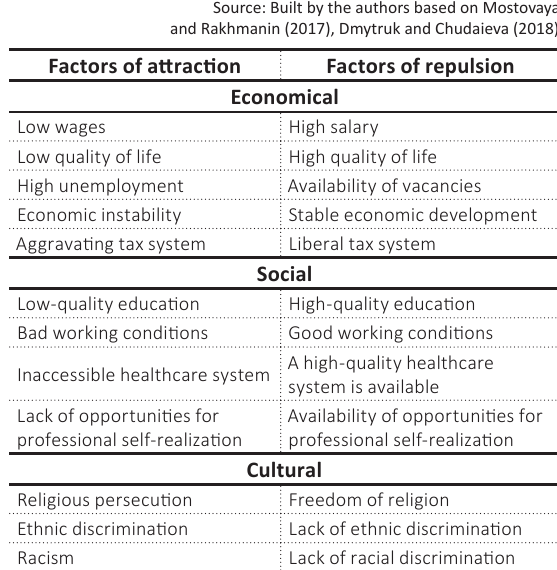
Table 1. Key factors of migration